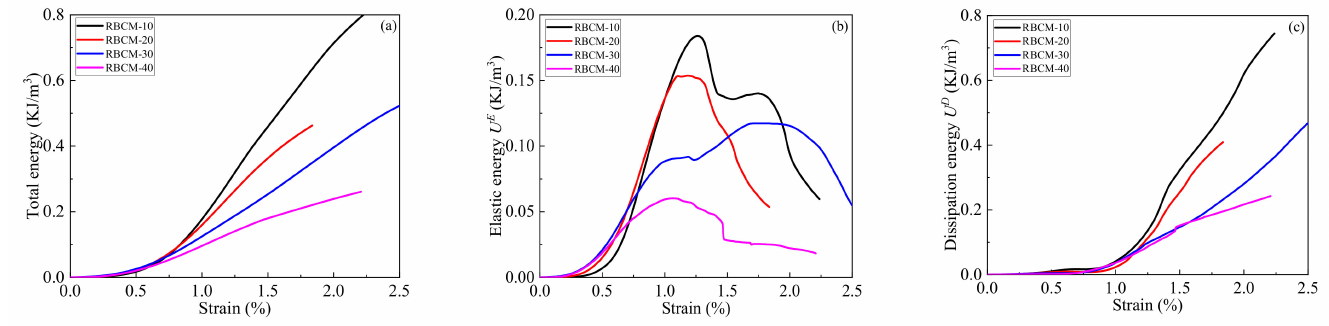
Figure 8. Different types of energy evolution: ( a ) total energy; ( b ) elastic energy; ( c ) dissipation energy.